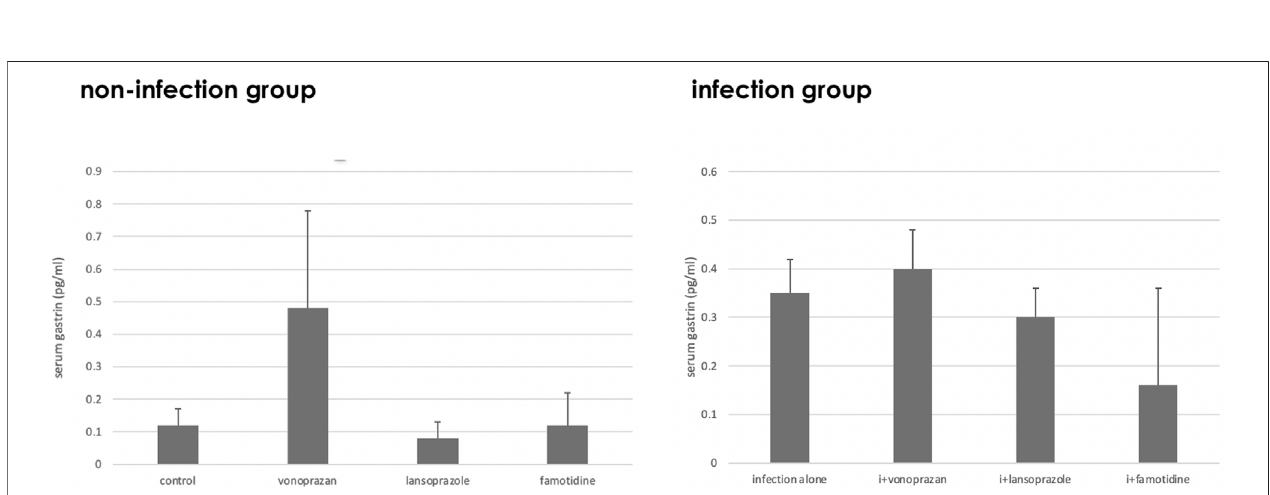
FIGURE 2 | Alteration of the serum gastrin level by acid suppressants and NHPH infection. A signi fi cant interaction was found between infection and acid suppressants in the serum gastrin level (F = 5.61; p = 0.003).